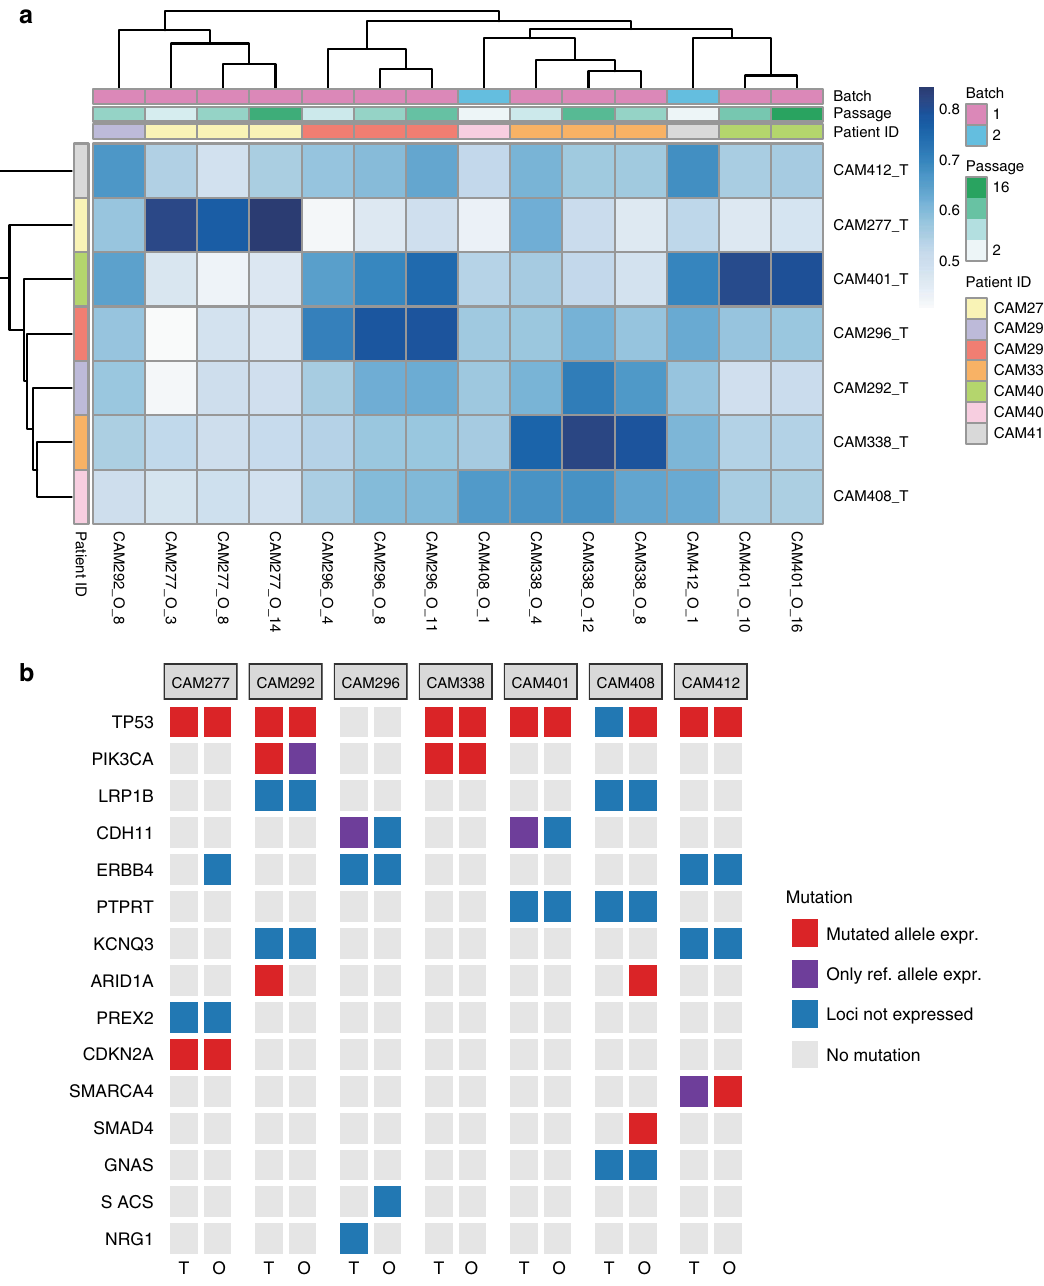
Fig. 4 Similarity of global gene expression and expressed mutations between tumors and organoid cultures. a Heatmap showing the Pearson correlation coef fi cient (color key) between tumors (rows) and organoids (columns) based on the normalized counts of tumor- and organoid-speci fi c genes. Dendrograms show the hierarchical clustering based on the complete method and Euclidean pair-wise distance. In some cases, multiple passages from the same organoid culture are included. b Mutations as in Fig. 2 colored by whether the mutated allele, the reference allele, or no expression were detected by